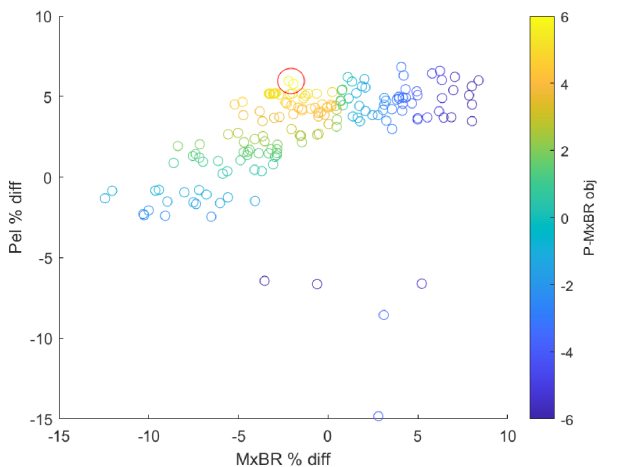
Figure 7. Pareto front of the evaluated